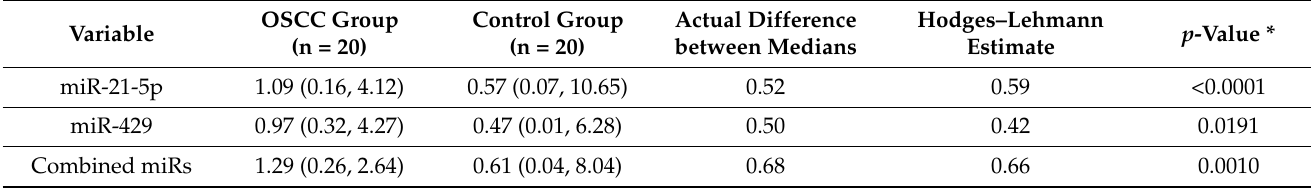
Table 2. Distribution [median (min, max)] of the expression of miRNAs among OSCC and control